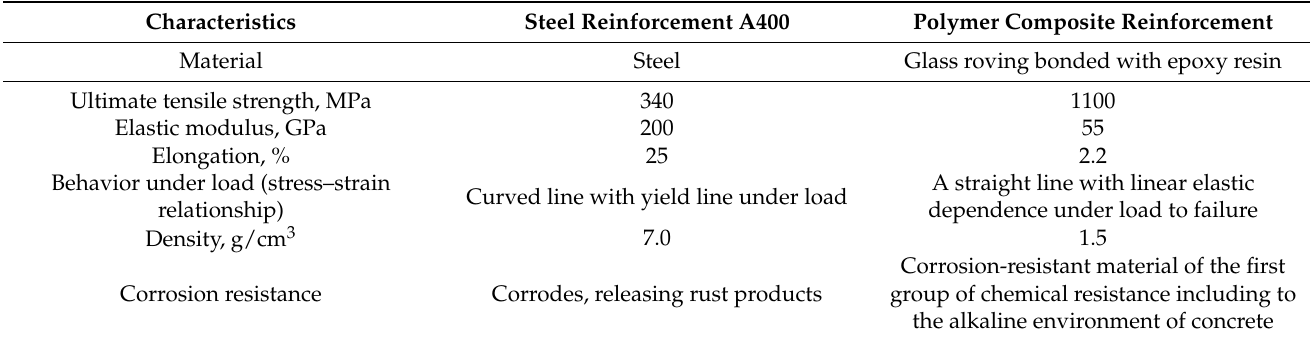
Table 5. Comparative characteristics of metal and composite reinforcement.